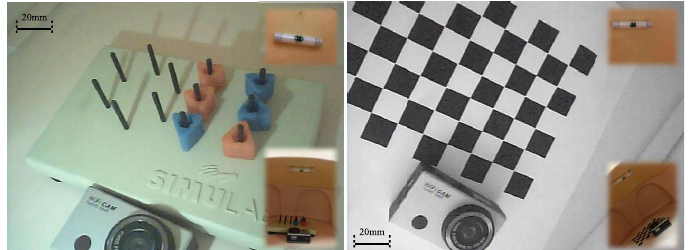
Figure 12. Wireless imaging performance test. A picture of the anchored s-CAM taken by a wifi cam- era is shown in a top-right insets. ( Left : Color imaging of a Peg Transfer Board; Right : Monochrome grid